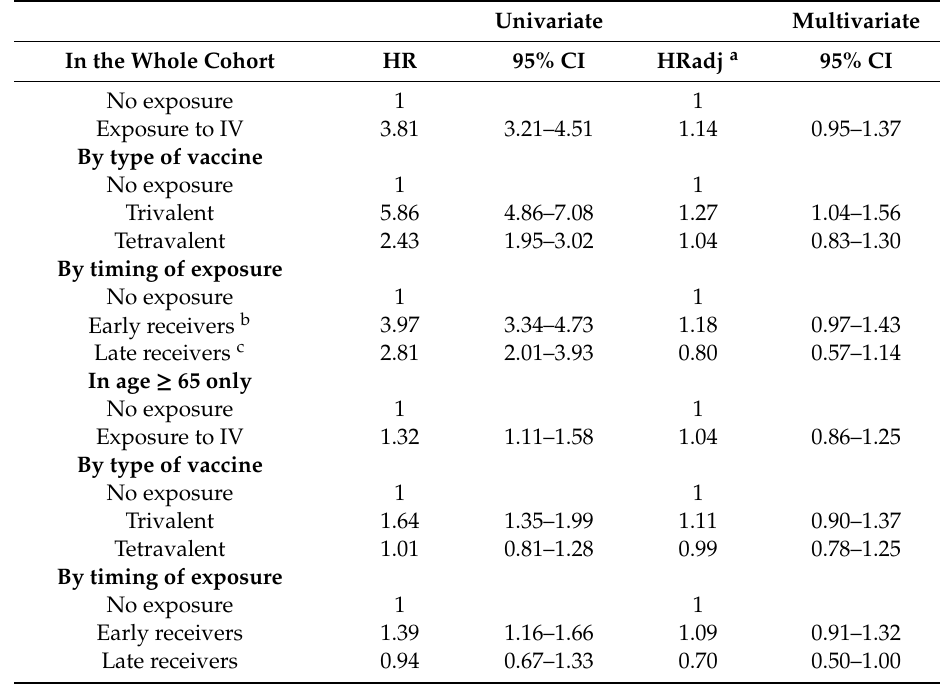
Table 5. Results of univariate and multivariate analyses on time from diagnosis to death, according to previous exposure to influenza vaccine (IV), in whole cohort of covid-19 patients, and in the age group > 65 years Secondary analyses in gray background. Univariate